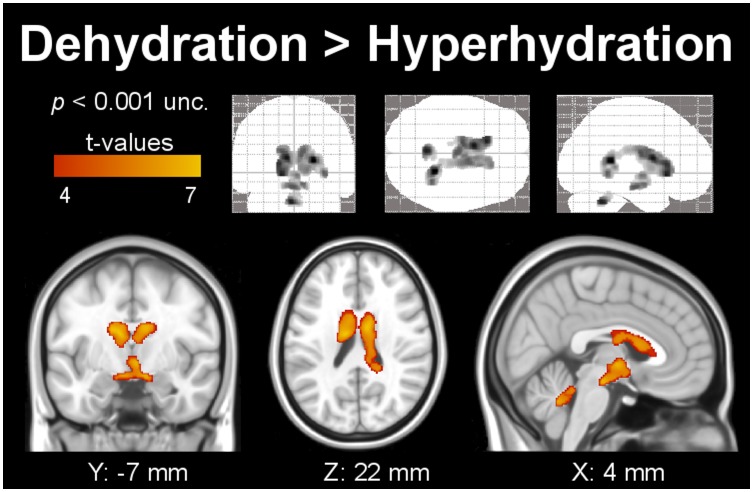
Segmented clusters of the cerebrospinal fluid system with significant extension during dehydration compared to hyperhydration in the third, fourth, and both lateral ventricles (indicated by the color code) obtained with VBM.The upper row shows the results as grayscale Maximum Intensity Projection onto the standard SPM glass brain in coronal, axial and sagittal view.